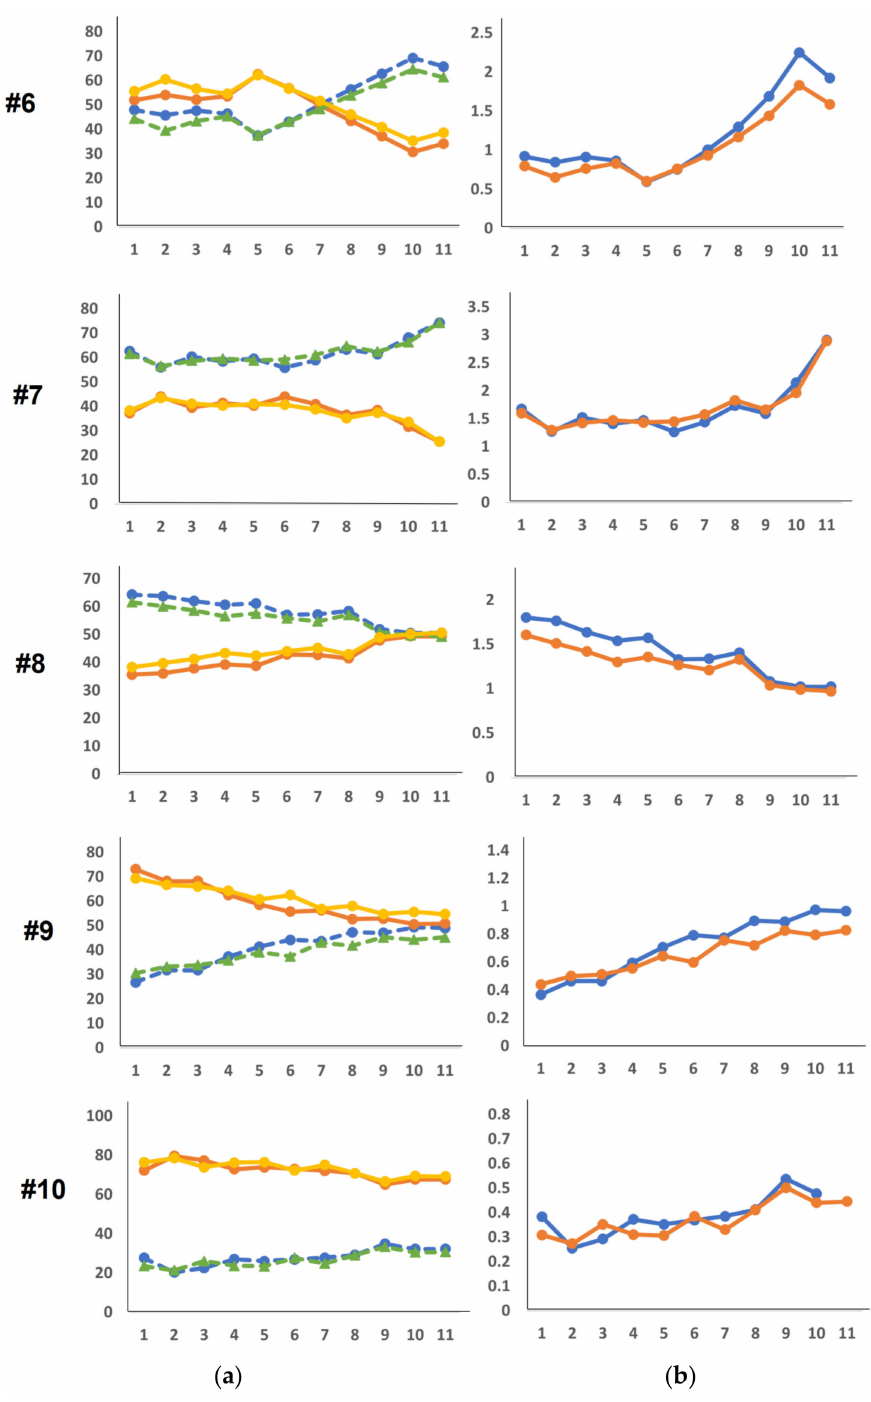
Figure 5. PRV frequency domain feature graphs of 10 subjects (( a ): low frequency (LF) and high frequency (HF), ( b ):